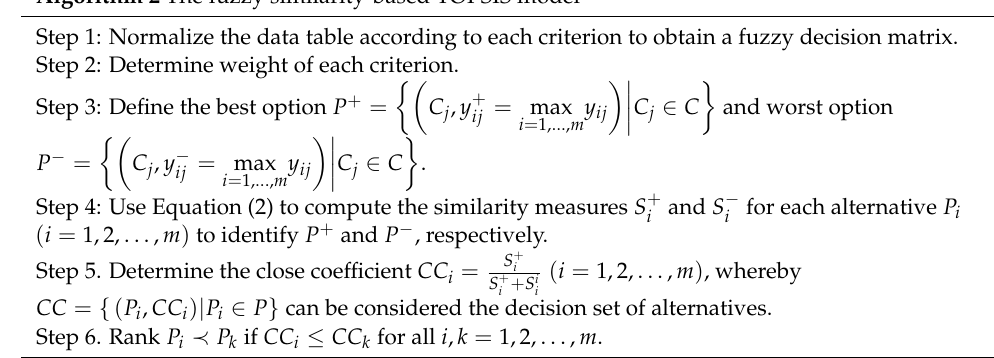
Algorithm 2 The fuzzy similarity-based TOPSIS